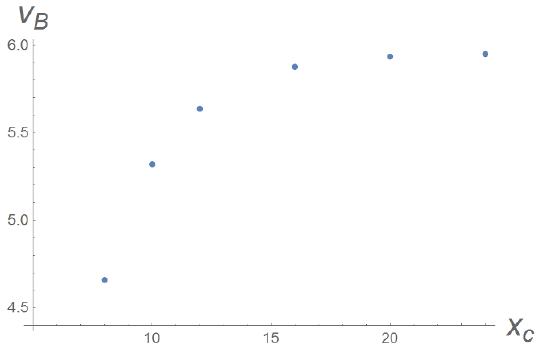
Figure 9 . The (cid:12)tted butter(cid:13)y velocity as a function of the center location x c